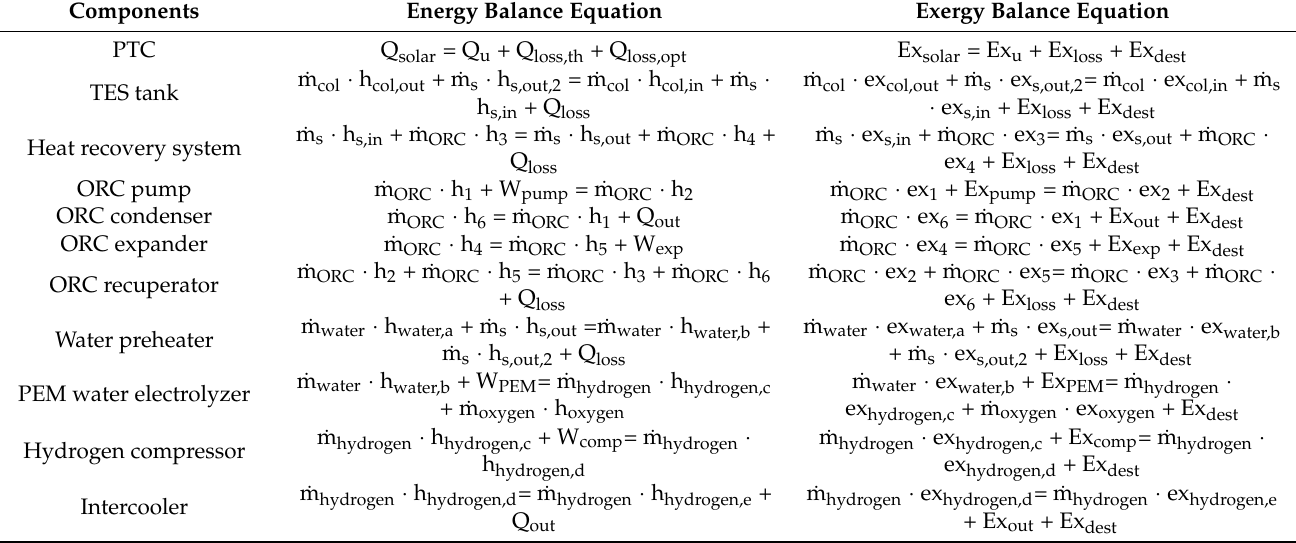
Table 2. Energy and exergy balance equations of the